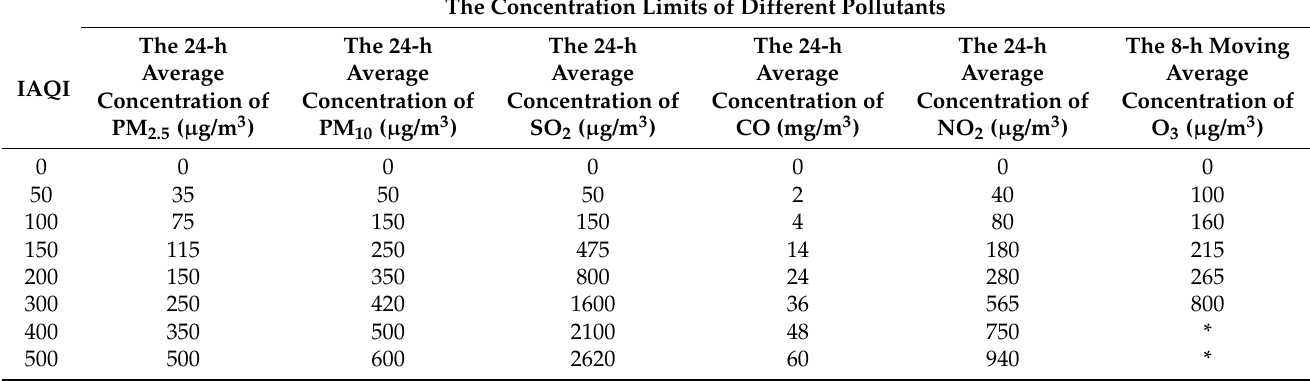
Table 1. The individual air quality index (AQI) and corresponding pollutant concentration